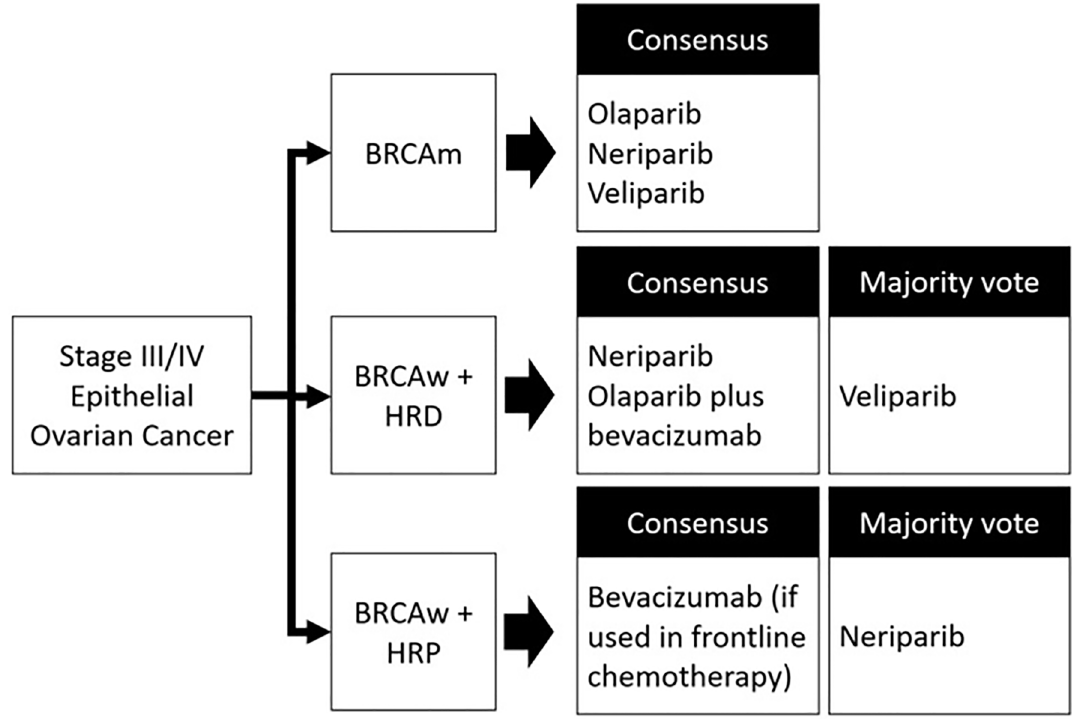
Figure 1. Panel recommendations for three groups of patients defined by BRCA status (m = Mutated; w = Wild-type) or homologous-re - combination status (HRD = Homologous-recombination deficient; HRP = Homologous-recombination